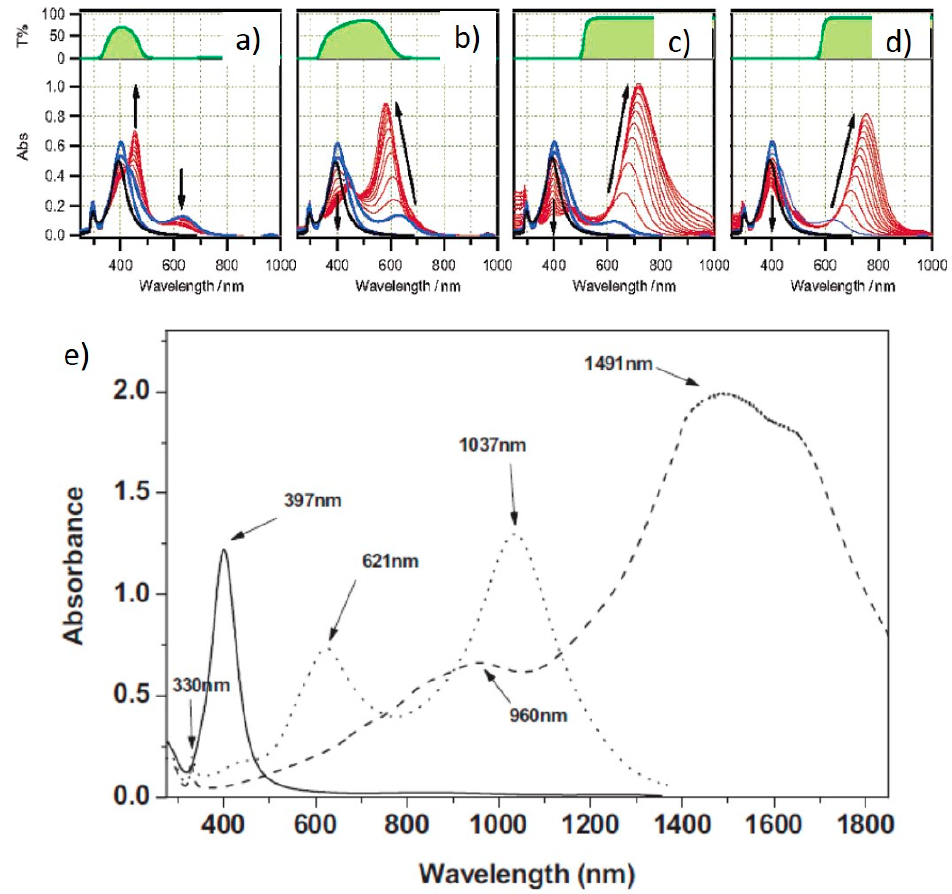
Figure 4. Absorption spectra of Ag NPs irradiated by different wavelengths [26,27]. ( a ) Narrow band color filter, ( b ) wide band color filter, ( c ) 515 nm band pass filter, ( d ) 590 nm band pass filter and ( e ) green (dotted line) and red (dashed line) LEDs, along with starting NPs (solid line). Adapted with permission from ref. [26], Copyright 2003 American Chemical Society ( a – d ). Reprinted with